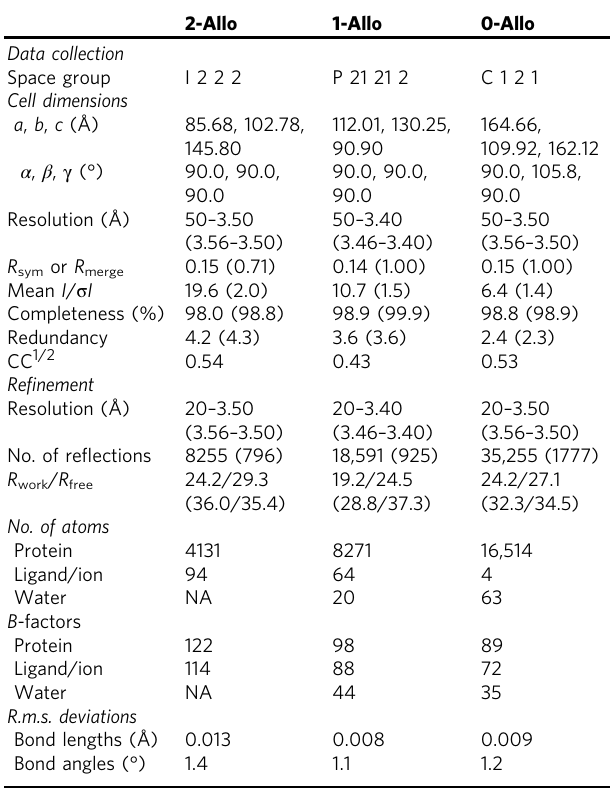
Table 1 Data collection and re fi nement statistics